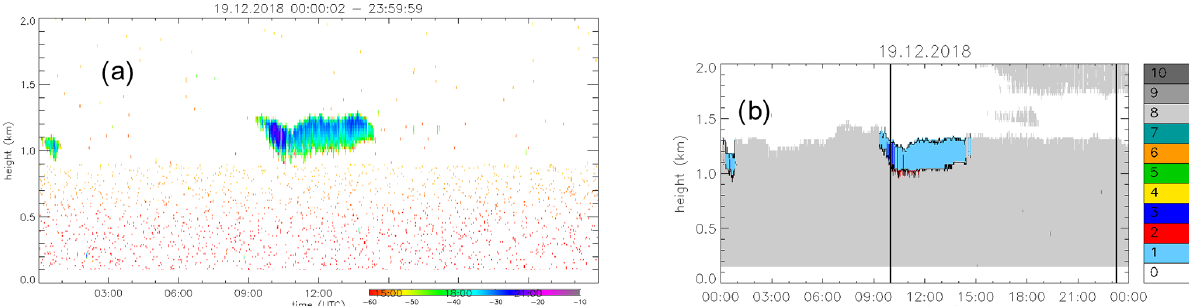
Figure B3. Like Fig. A3 for 19 December